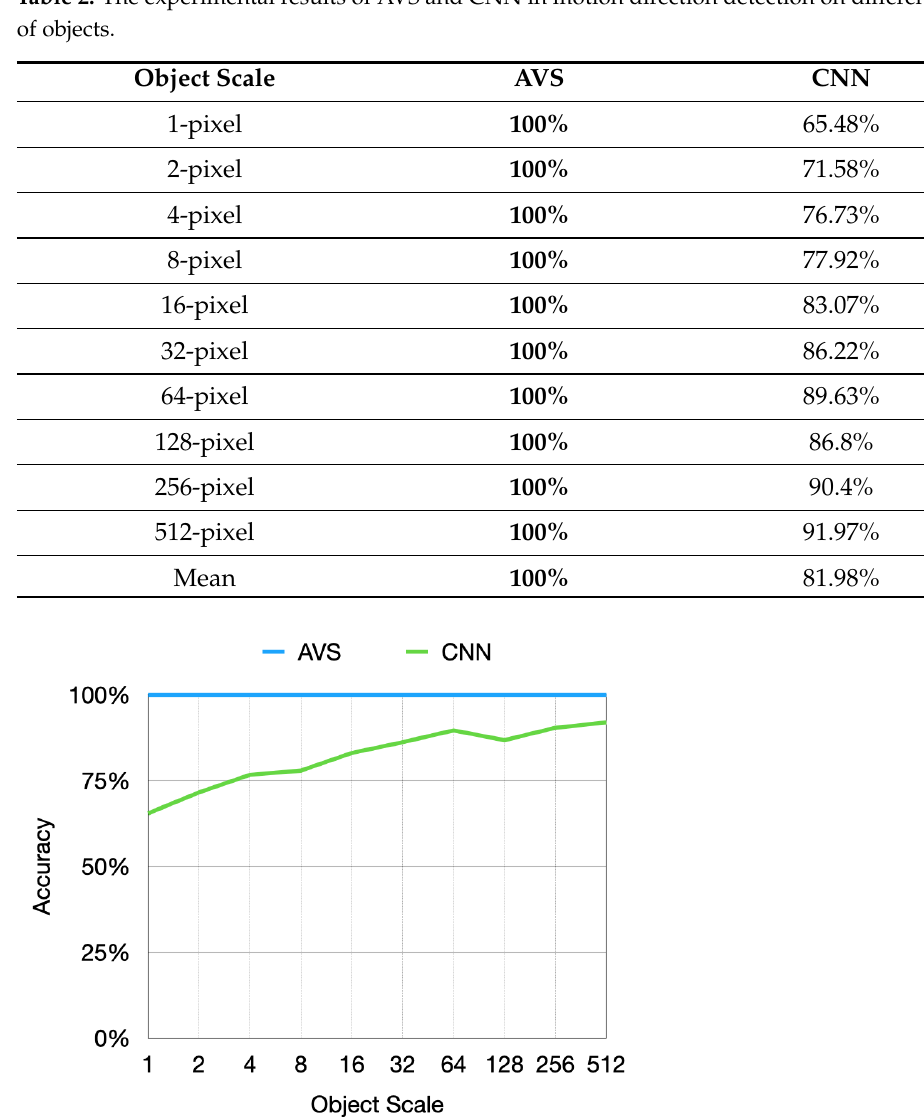
Figure 10. The detection accuracy trends of AVS and CNN to motion direction of different scales of